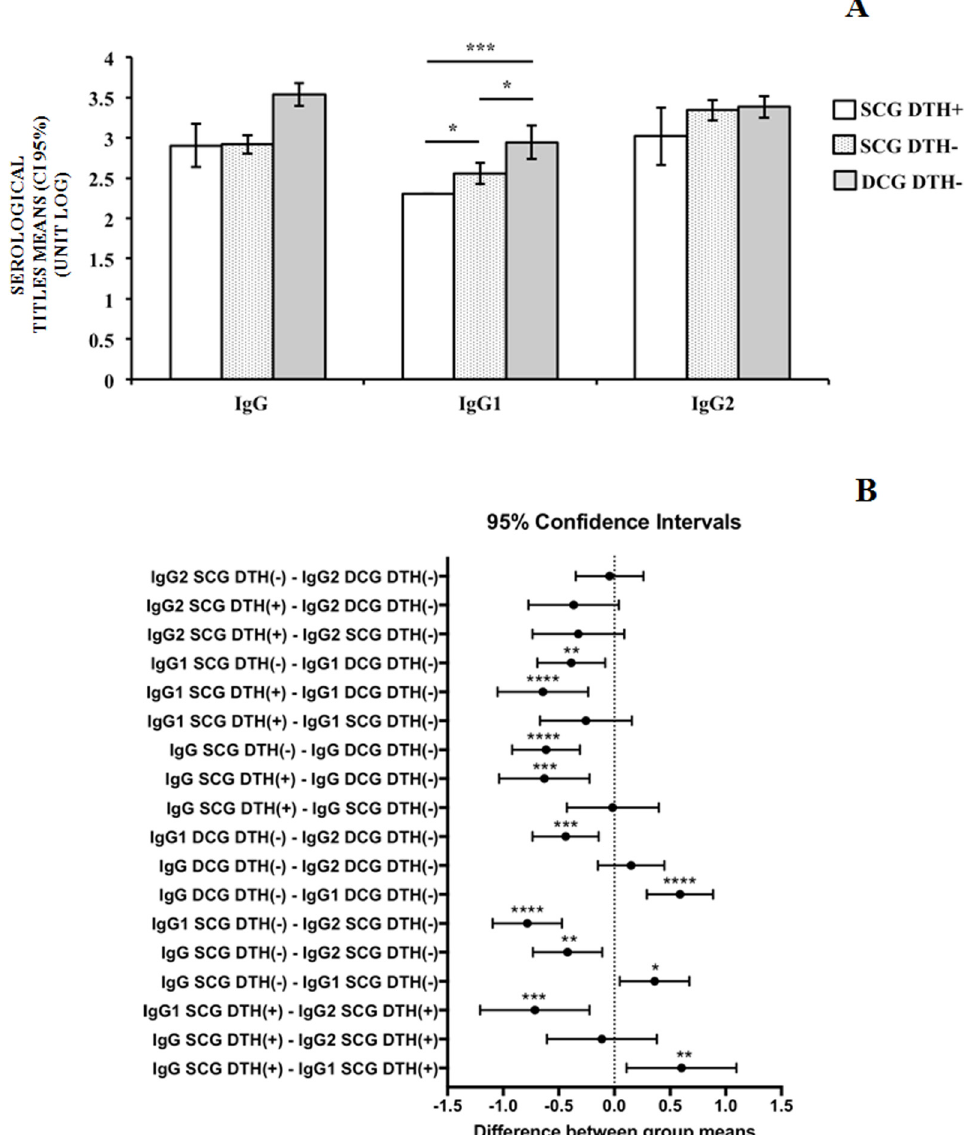
Figure 4. The 95% con fi dence intervals of the differences between the mean titers of IgG, IgG1, and IgG2 obtained by ELISA, considering the variables of clinical states and DTH results together. The vertical dotted line de fi nes the absence of differences between the means evaluated. * , p =0.0105; ** (IgG SCGDTH ( + ) – IgG1 SCGDTH ( + ) ), p = 0.0054; ** (IgG SCG DTH ( (cid:1) ) ) – IgG2SCG DTH ( (cid:1) ) ), p = 0.0012; ** (IgG1SCGDTH ( (cid:1) ) – IgG1 DCGDTH ( (cid:1) ) ), p =0.0031; *** (IgG1SCG DTH ( + ) – IgG2SCG DTH ( + ) ), p = 0.0004; *** (IgG1 DCGDTH ( (cid:1) ) – IgG2 DCGDTH ( (cid:1) ) ), p =0.0003; *** (IgG SCGDTH ( + ) – IgG DCGDTH ( (cid:1) ) ), p =0.0001; **** , p <